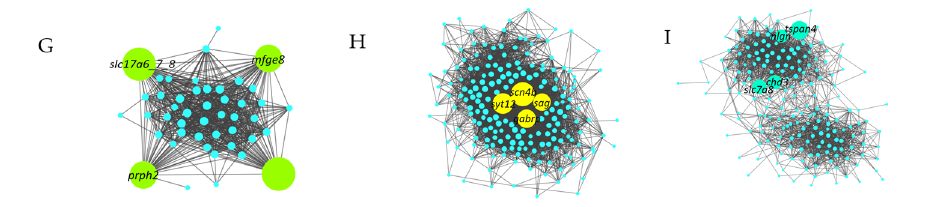
Figure 8. Protein–protein interaction (PPI) network for eight target modules in clearhead icefish, predicted by Cytoscape. Each node labelled with the abbreviation of gene ID represents a gene. The node size represents the degree value, and the color of the candidate hub gene is consistent with the color of the corresponding module: ( A ) Brown module; ( B ) red module; ( C ) purple module; ( D ) grey module; ( E ) cyan module; ( F ) pink module; ( G ) lightcyan module; ( H ) yellow module; ( I ) turquoise module.